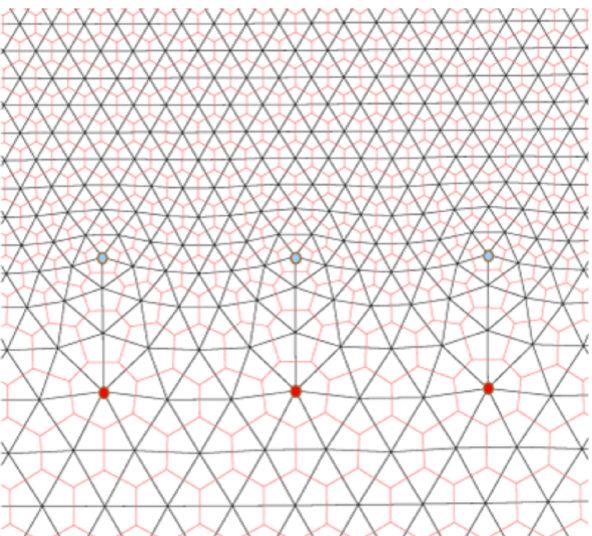
Figure 2. Detail of one step of local mesh refinement used by the OLAM Voronoi mesh. The transition zone is constructed by explicit topological reconnection of the grid lines, which produces pairings of heptagons (red dots) and pentagons (blue dots) along the refine- ment perimeter.